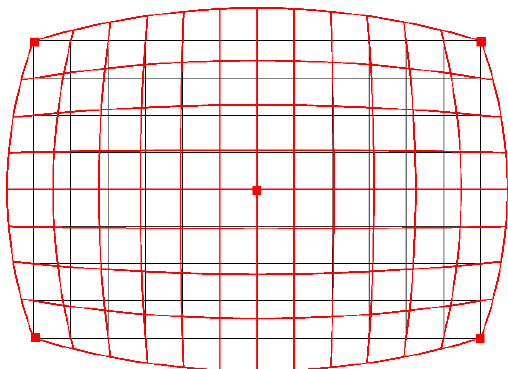
Figure 4. The barrel distortion (red) against the background of a standard grid of squares (black).